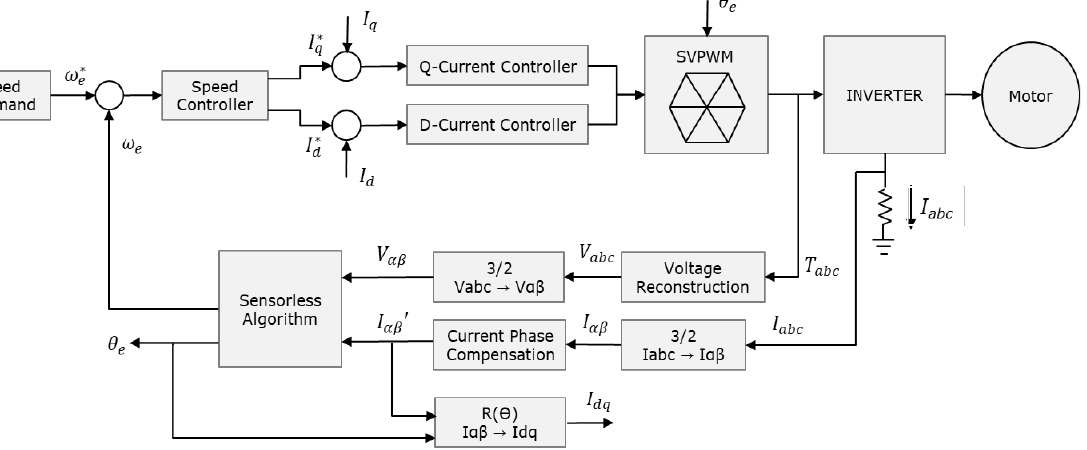
Figure 9. Controller block diagram of 1-shunt sensorless 3-phase inverter.